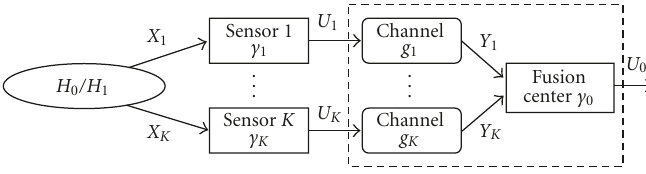
Figure 1: A block diagram for a wireless sensor network tasked for binary hypothesis testing with channel fading